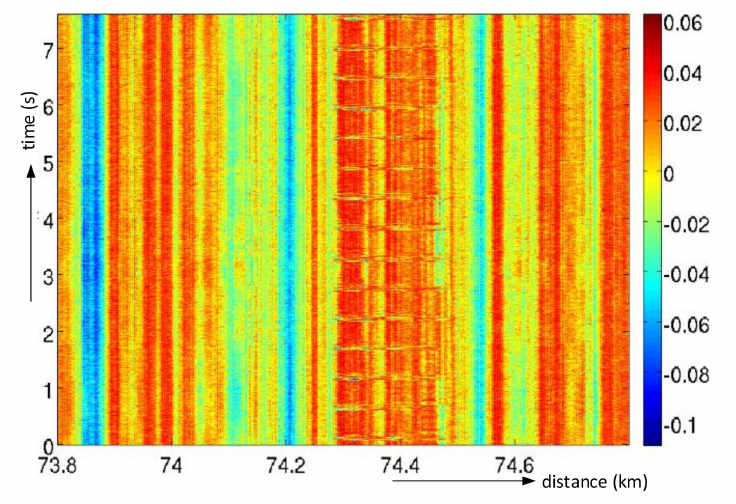
Figure 17. A “waterfall” of raw captured data. Using FIR filtering with linear phase response along the time axis, the vibration events along the fiber can be emphasized, while the quiet areas are cleaned, as shown in Figure 18.